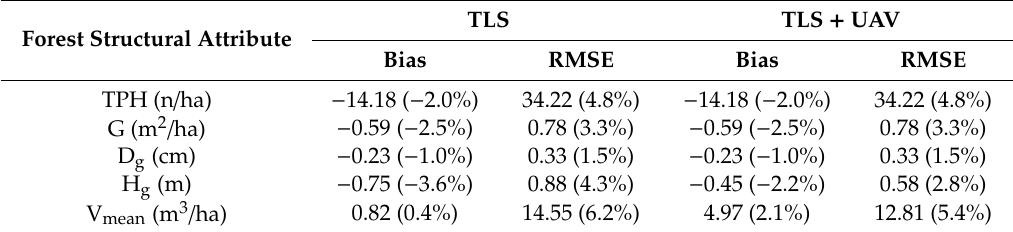
Table 2. The accuracy of the estimated forest structural attributes, such as trees per hectare (TPH), basal area (G,), basal-area weighted mean diameter (D g ), basal-area weighted mean height (H g ), and mean stem volume (V mean ) using the terrestrial laser scanning (TLS) and the combination of the TLS and the unmanned aerial vehicle (UAV) point clouds. A negative bias denotes underestimation. TLS TLS + UAV Forest Structural Attribute Bias RMSE